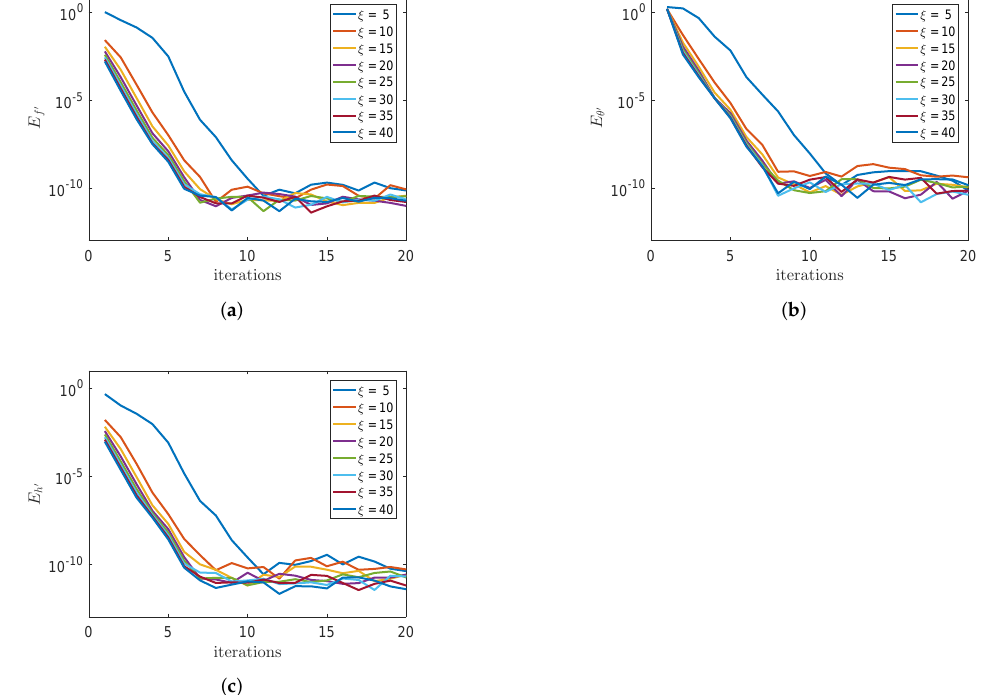
Figure 3. Error in ( a ) f (cid:48) ( η , ξ ) ( b ) θ (cid:48) ( η , ξ ) , and ( c ) h (cid:48) ( η , ξ ) for different values of ξ